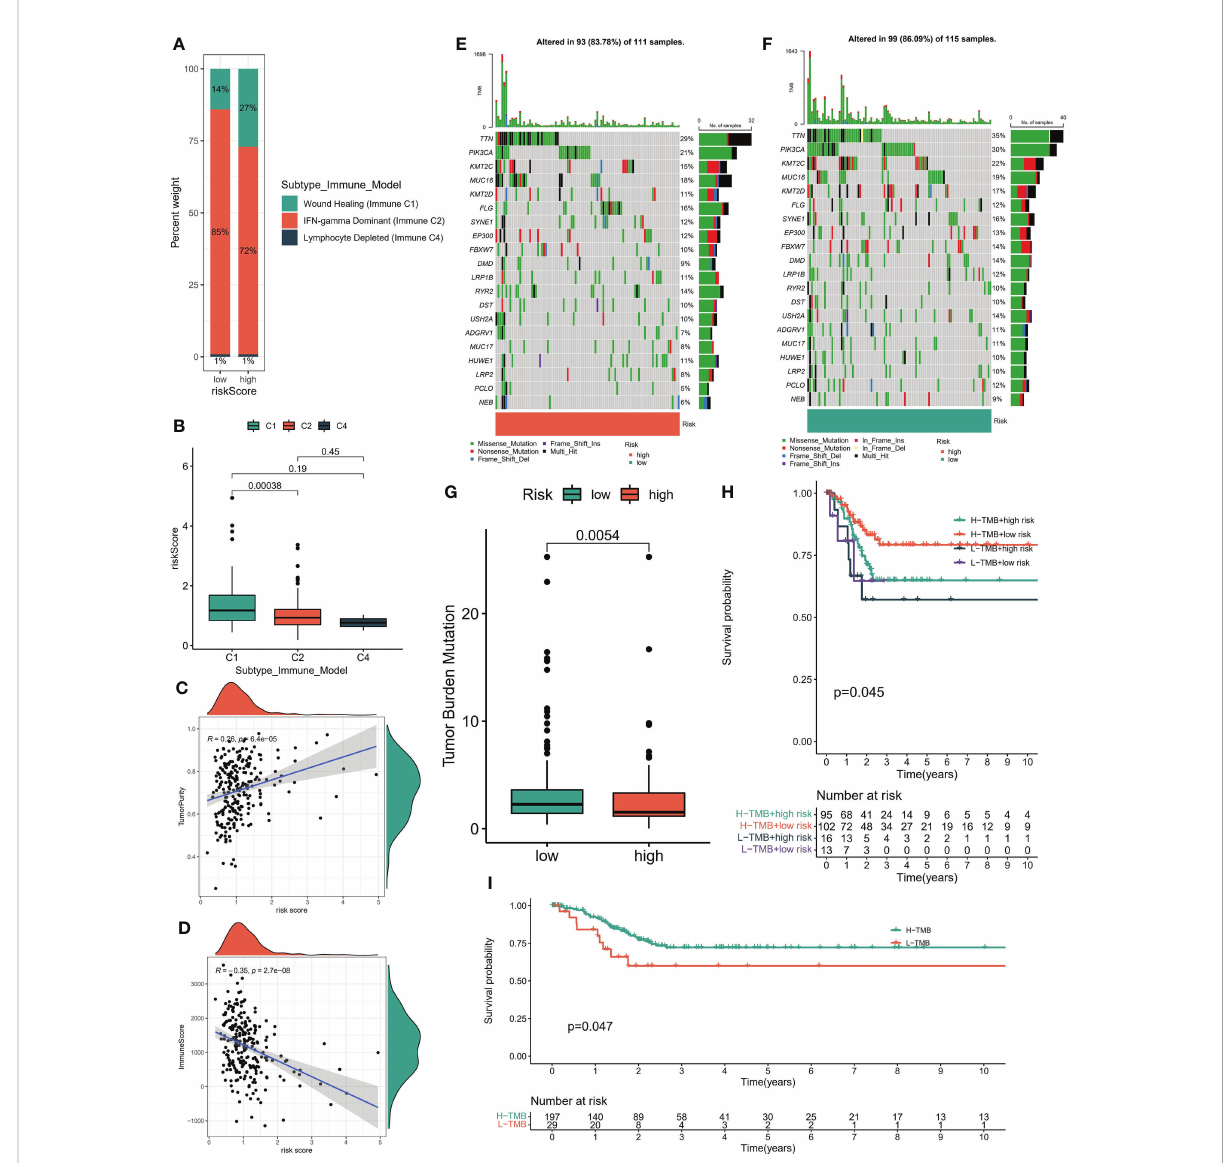
FIGURE 6 (A) Proportion of immune subsets among different risk subgroups. (B) Riskscore of immune subsets. (C, D) Correlation between risk score and StromalScore, ImmuneScore which obtained by “ ESTIMATE ” algorithm. (E, F) Global mutation landscape of high and low risk subgroups. (G) Tumor mutation burden score for high - and low-risk subsets. (H) The K-M algorithm was used to evaluate the predictive performance of the risk model +TMB model. (I) K-M algorithm was used to evaluate the prediction performance of TMB